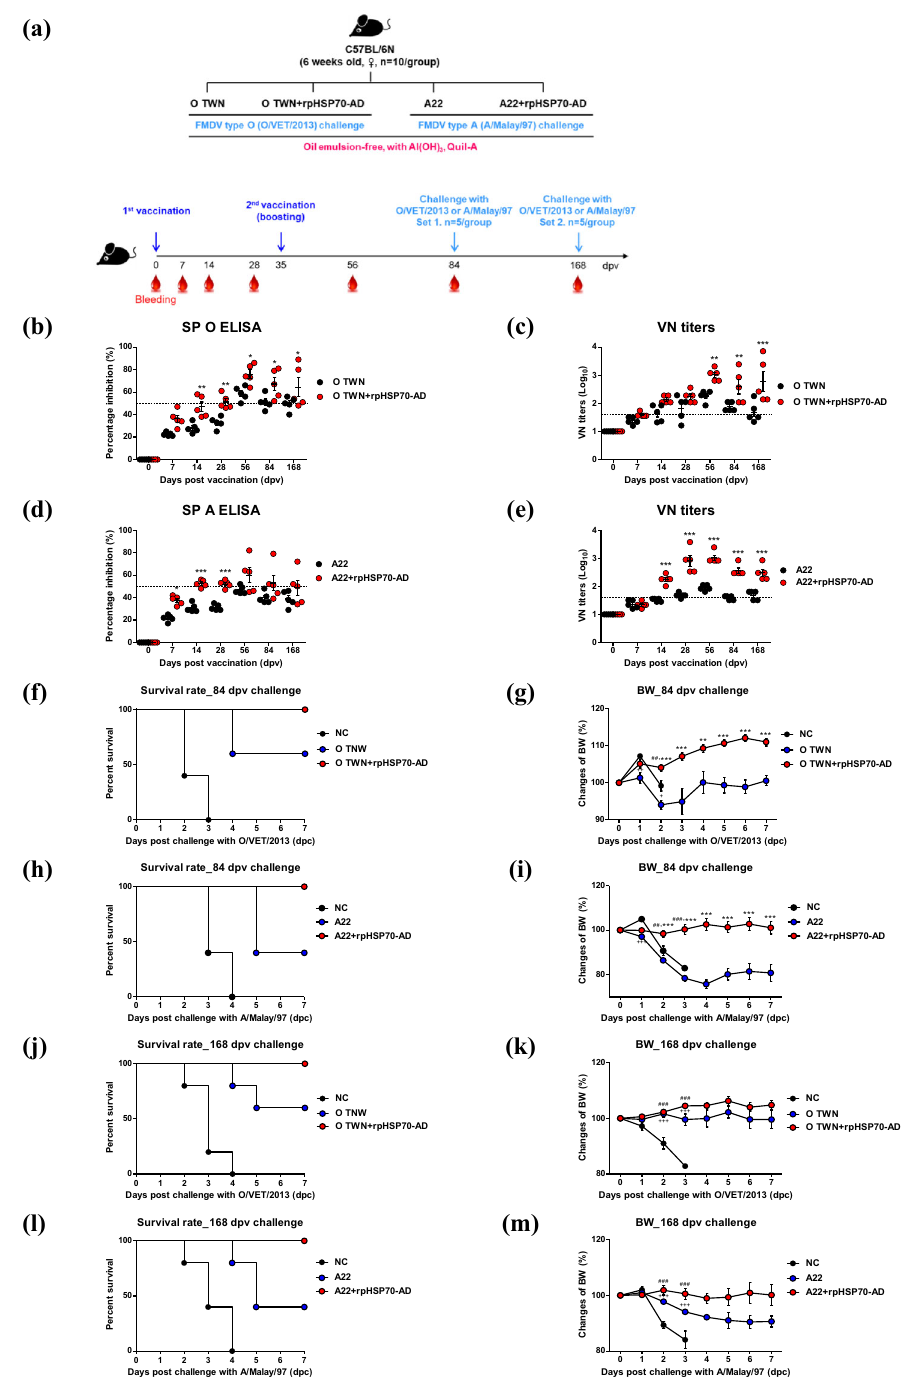
Fig. 4 rpHSP70-AD mediated early, mid-term, and long-term immune responses and host defense against FMDV infection in mice. C57BL/6 mice ( n = 5/group) were administered oil emulsion-free test vaccines, including O TWN antigen, A22 antigen, or combined O TWN and A22 antigens with rpHSP70-AD. The positive control received 1.5 μ g (1/10 dose for cattle and pig use) O TWN antigen or A22 antigen without (w/ o) oil emulsion, 10% Al(OH) 3 , and 15 μ g Quil-A. The negative control received the same volume of PBS. Vaccination was performed twice at 35- day intervals. Study strategy ( a ); antibody titers by SP O ELISA ( b ); O/TWN/97 VN titers ( c ); antibody titers by SPA ELISA ( d ); A22/IRAQ VN titers ( e ); survival rate at 84 days post-vaccination challenge with FMDV O (O/VET/2013) ( f ); changes in body weight at 84 days post-vaccination challenge with FMDV O (O/VET/2013) ( g ); survival rate at 84 days post-vaccination challenge with FMDV A (A/Malay/97) ( h ); changes in body weight at 84 days post-vaccination challenge with FMDVA (A/Malay/97) ( i ); survival rate at 168 days post-vaccination challenge with FMDV O (O/VET/2013) ( j ); changes in body weight at 168 days post-vaccination challenge with FMDV O (O/VET/2013) ( k ); survival rate at 168 days post-vaccination challenge with FMDVA (A/Malay/97) ( l ); changes in body weight at 168 days post-vaccination challenge with FMDVA (A/Malay/97) ( m ). The data represent the mean ± SEM of triplicate measurements ( n = 5/group). Statistical analyses involved two-way ANOVA with Bonferroni correction. + p < 0.05; ++ p < 0.01; and +++ p < 0.001: NC vs PC (O TWN- or A22-only group); # p < 0.05; ## p < 0.01; and ### p < 0.001: NC vs Exp. (O TWN + rpHSP70- AD or A22 + rpHSP70-AD group); * p < 0.05; ** p < 0.01; and *** p < 0.001: PC vs